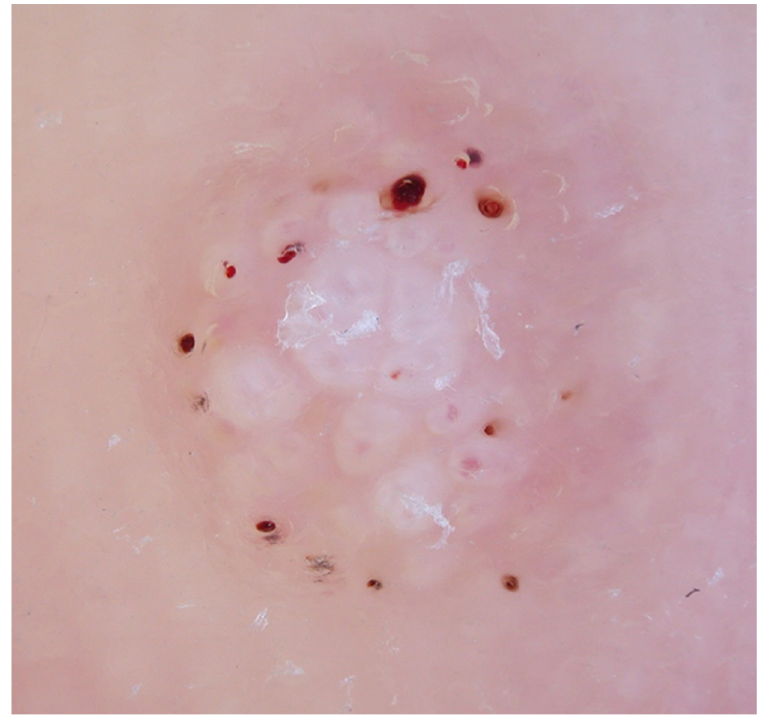
Figure 1. Dermoscopy of a debrided plantar wart showing a frog spawn like appearance with white halos, with capillaries at the centre of the lesion.